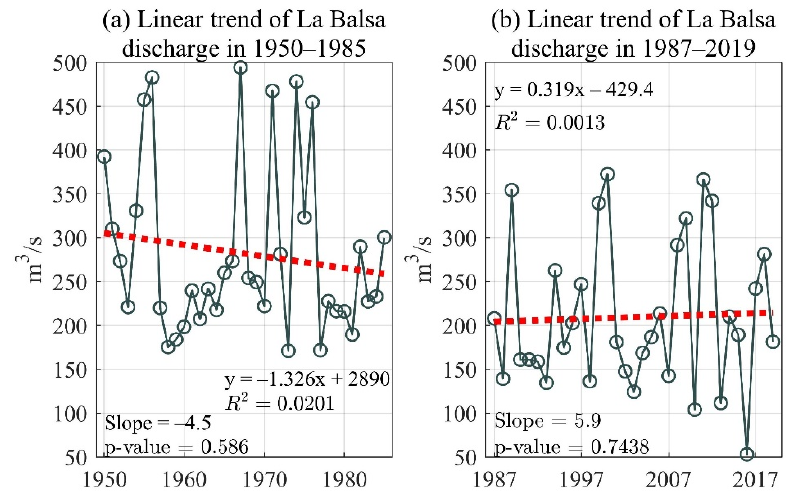
Figure 3. ( a ) Linear trend of La Balsa discharge during 1950–1985 period, and ( b ) during 1987–2019 period from November to January (NDJ). The red dotted line represents the linear trend of the dis- charge time series for each period.